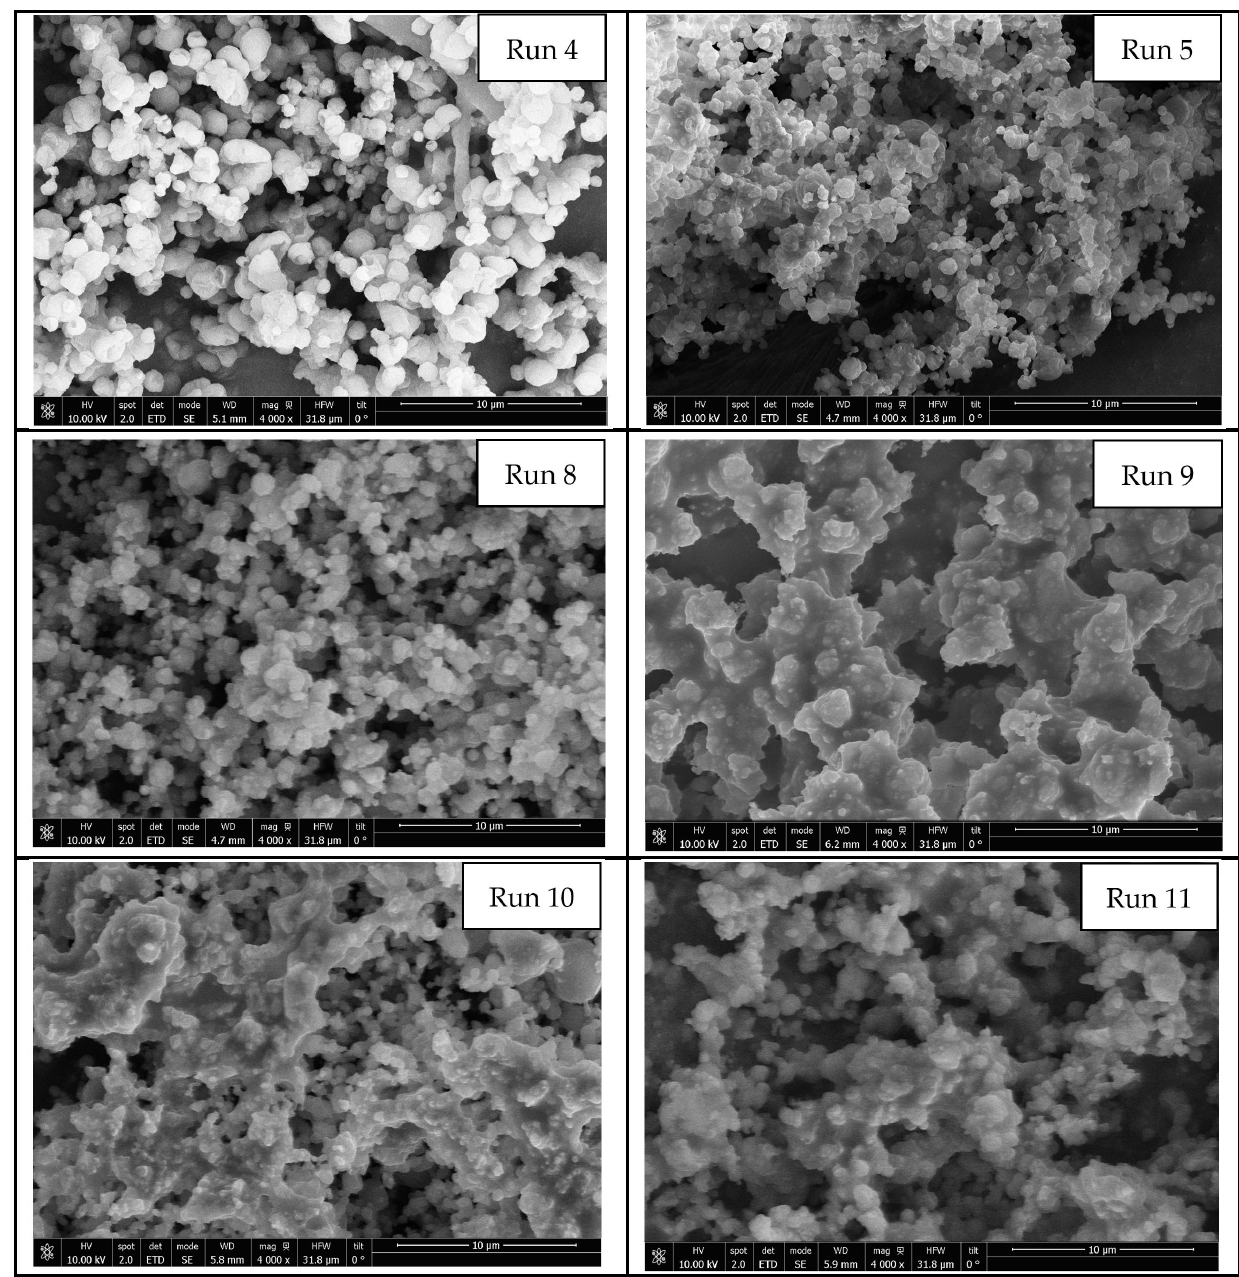
Figure 2. SEM images of the particles precipitated from myrtle leaf extracts. No free powder precipitate was obtained from runs 1, 2 and 3, but a sticky mixture was obtained, which makes any measurement on it difficult. Based on the study by Rever- chon and De Marco, larger particle sizes and non-uniform precipitates are obtained when the operating values do not reach into the supercritical single-phase region of the vapor- liquid equilibrium diagram of the CO 2 -organic solution mixture [47]. This is in agreement with the results obtained in runs performed at low pressure (9 MPa—run 4), where clus- ters based on solid particles larger than one-micron size stuck together were obtained. Figure 3 shows the powder precipitated on a vessel corresponding to run 5. In general, submicron quasi-spherical particles can be observed when operating at not extremely high pressures and mild temperatures, as in run 5. This probably happens because when operating just above the supercritical conditions of the mixture, its surface tension be- comes zero, especially at the end of the mixing process [47].